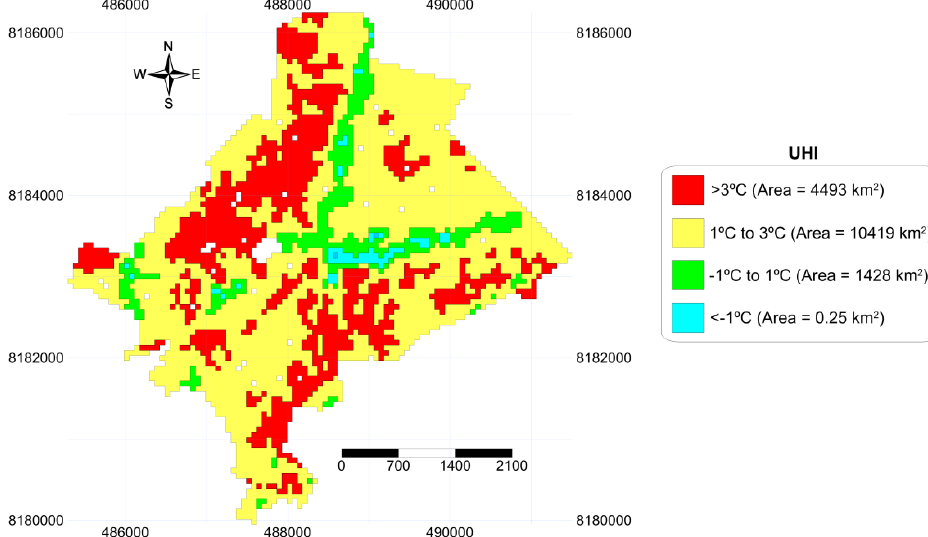
Figure 8. Areas of UHI and cool island classes.